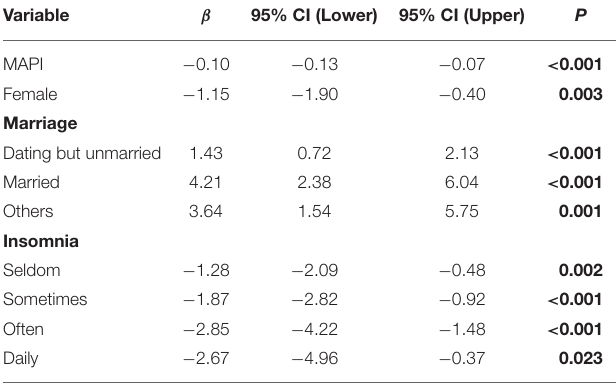
TABLE 4 | Association of PMPU and SWLS.